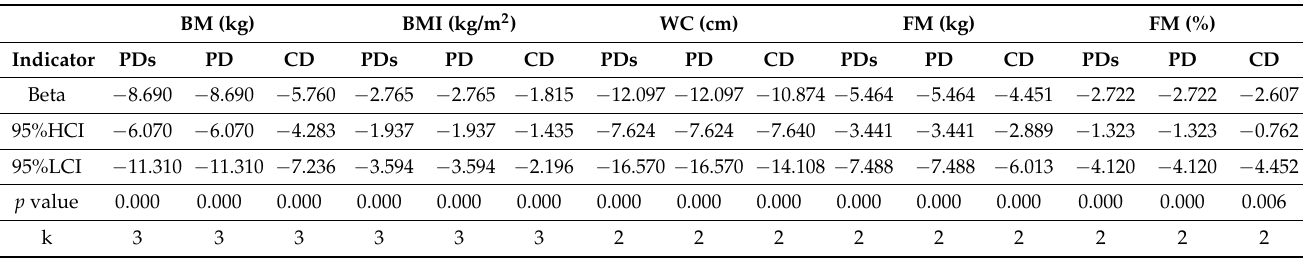
Table 3. Changes in body composition (body mass, body mass index, waist circumference, and fat mass in kg and %) in long-term PDs, PD, and CD studies (over 6